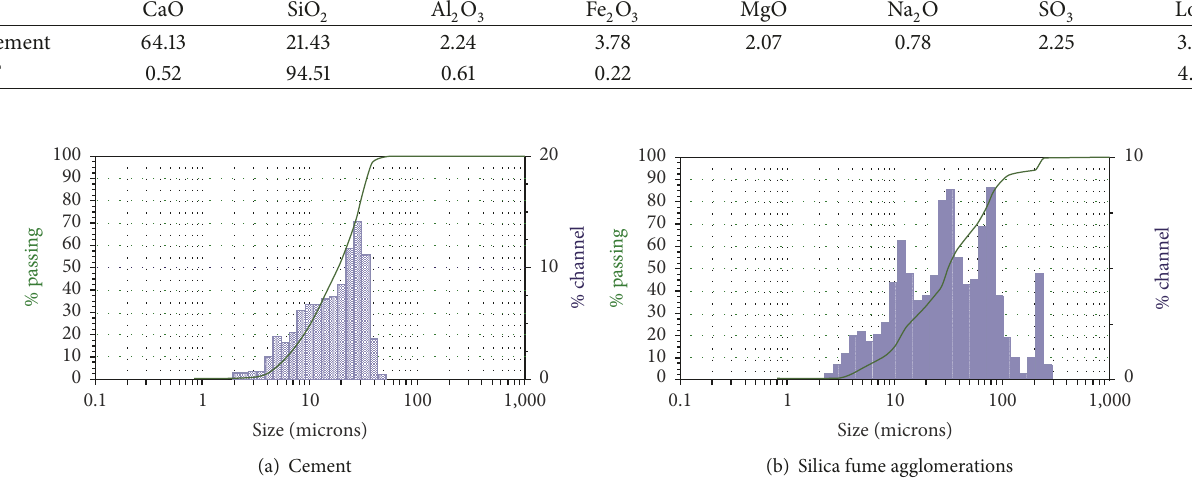
Figure 1: Particle size distribution of powder